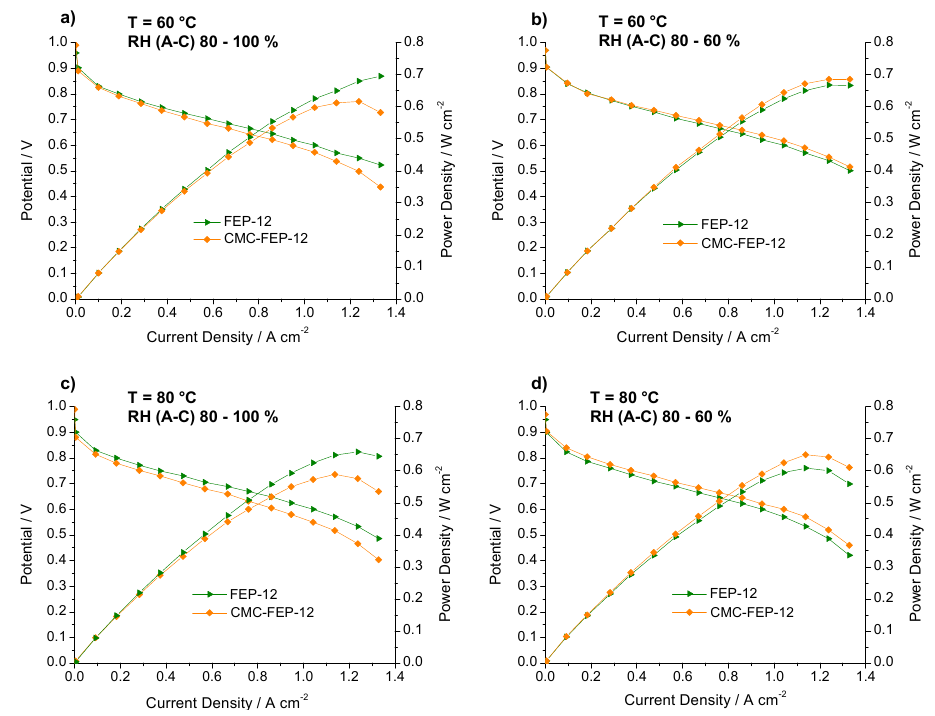
Figure 9. Polarization and power density curves of FEP-12 and CMC-FEP-12 assembled fuel cells. Operating conditions: ( a ) 60 °C, RH (A-C): 80–100%; ( b ) 60 °C, RH (A-C): 80–60%; ( c ) 80 °C, RH (A-C): 80–100%; and ( d ) 80 °C, RH (A-C): 80–60%.